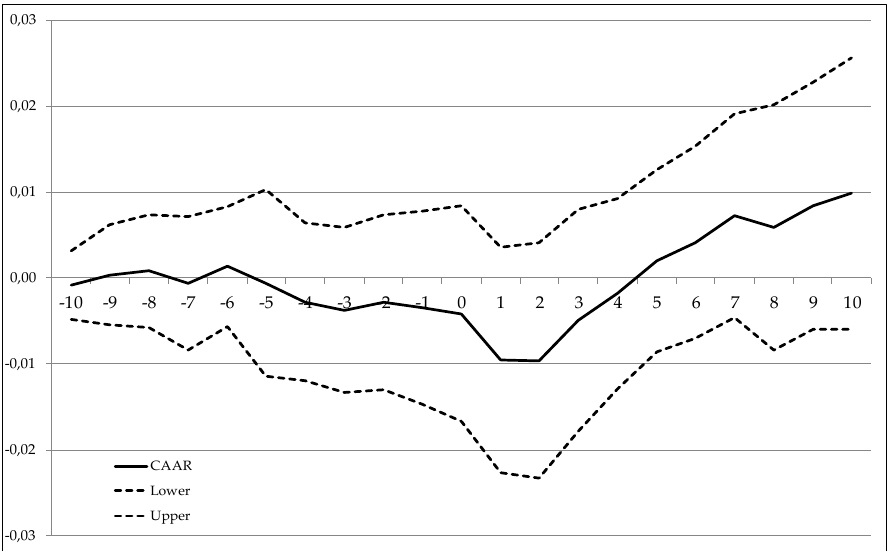
Figure 1. CAR τ for all markets, CEE regional market factor, with 95%